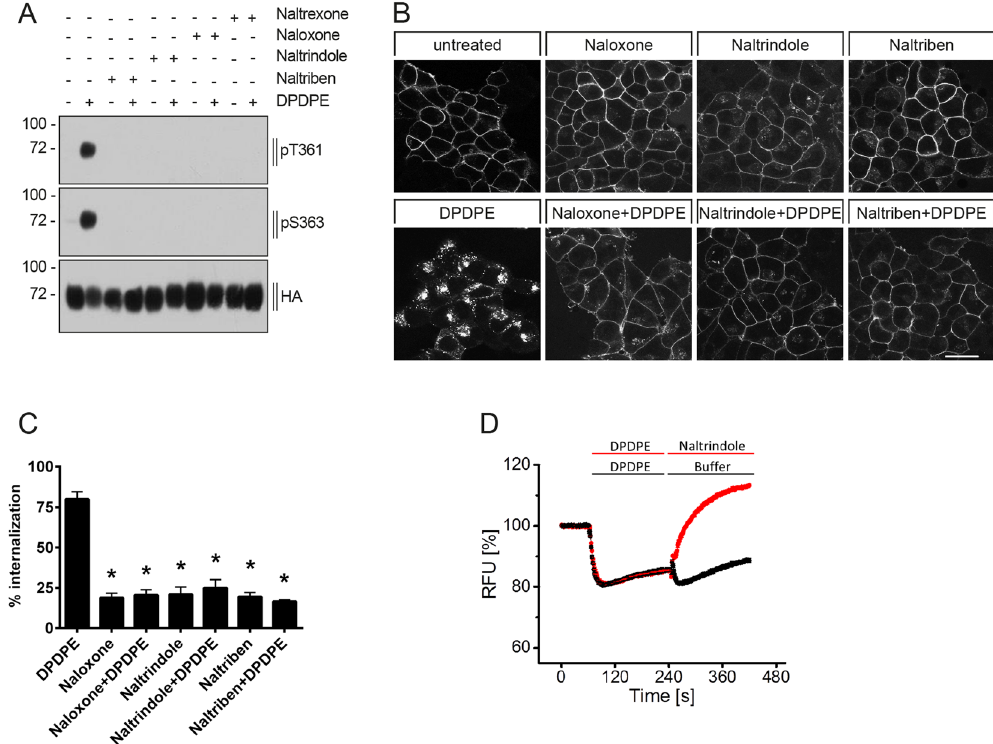
Figure 6. Antagonist-selective inhibition of DPDPE-induced DOP receptor phosphorylation, internalization and G protein signaling. ( A ) Stably HA-hDOP receptor-expressing HEK293 cells were either not preincubated ( − ) or preincubated ( + ) with 5 µ M naloxone, naltrindole, naltriben or naltrexone for 30 min at 37 °C, then stimulated with vehicle (water, -) or with 1 µ M DPDPE ( + ) for 10 min at 37 °C. Cell lysates were then immunoblotted with antibodies to pT361 or pS363. Blots were stripped and reprobed with the anti-HA antibody. Blots are representative, n = 4. (B) Cells described in ( A ) were preincubated with anti-HA antibody and then treated with vehicle (DMSO), 5 µ M naloxone, naltrindole or naltriben and with or without 1 µ M DPDPE for 10 min at 37 °C. After fixation, cells were permeabilized, immunofluorescently stained and examined using confocal microscopy. Images are representative, n = 3. Scale bar, 20 µ m. (C) Cells described in ( A ) were preincubated with anti-HA antibody and stimulated with vehicle (DMSO), 5 µ M naloxone, naltrindole or naltriben and with or without 1 µ M DPDPE for 10 min at 37 °C. Cells were then fixed and labeled with a peroxidase-conjugated secondary antibody. Receptor internalization was measured by ELISA and quantified as percentage of internalized receptors in agonist-treated cells. Data are means ± SEM from five independent experiments performed in quadruplicate. * p < 0.05 vs. DPDPE by one-way ANOVA with Bonferroni post-hoc test. ( D ) Reversal of DPDPE-induced hyperpolarization by naltrindole using a fluorescence-based membrane potential assay. After baseline recording for 60 sec, HA-hDOP receptor -expressing AtT-20 cells were exposed to 1 µ M DPDPE and 240 sec later, 10 µ M naltrindol was added, yielding a final molar DPDPE/antagonist ratio of 1:10. Shown are the normalized traces obtained from the average of four individual experiments performed in